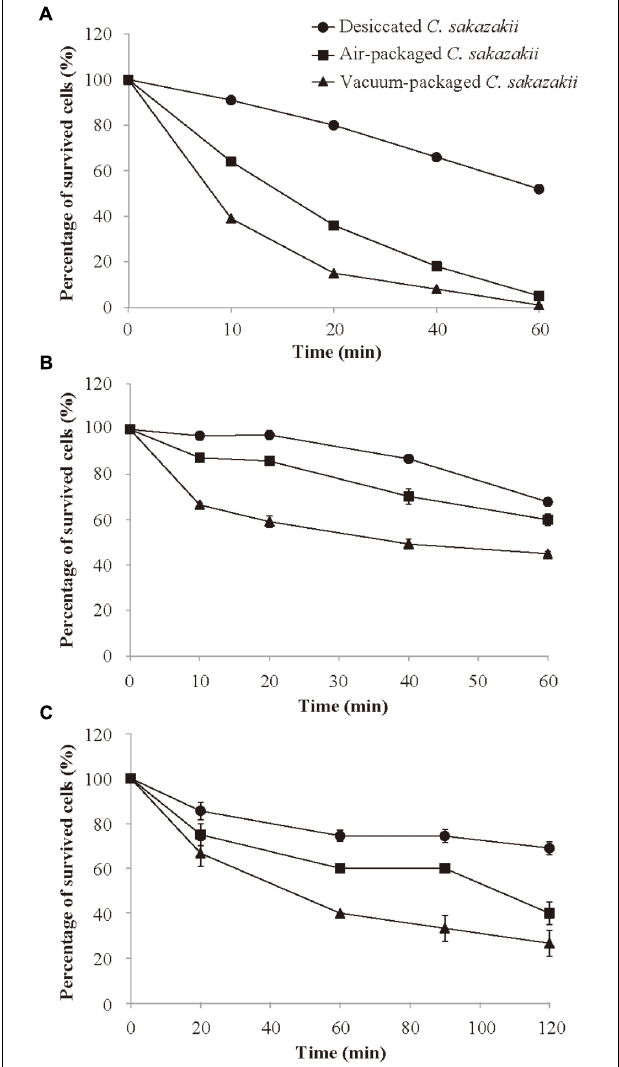
FIGURE 2 | Survival of desiccated, air-packaged, or vacuum-packaged C. sakazakii in heat environment (A) , simulated gastric fluid (B) , and simulated bile salt (C) . Values are means ± standard deviation of three